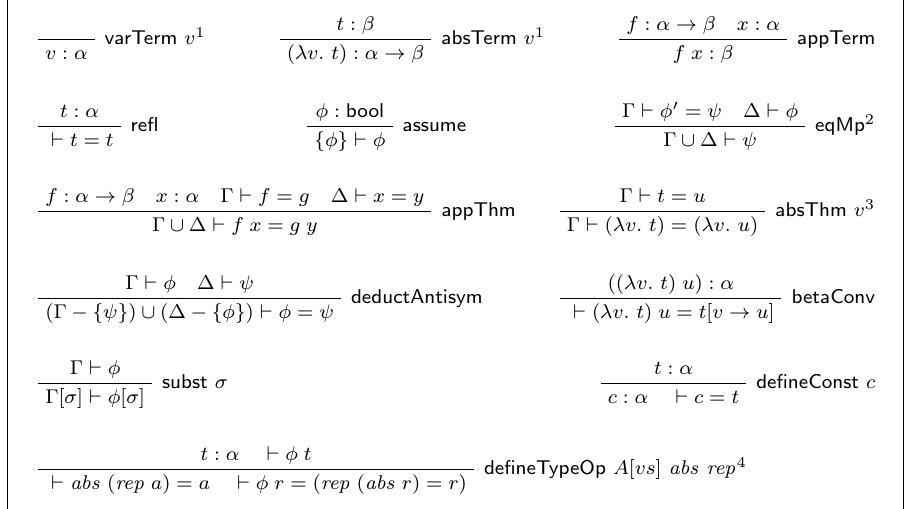
Fig. 1. The OpenTheory logical kernel.